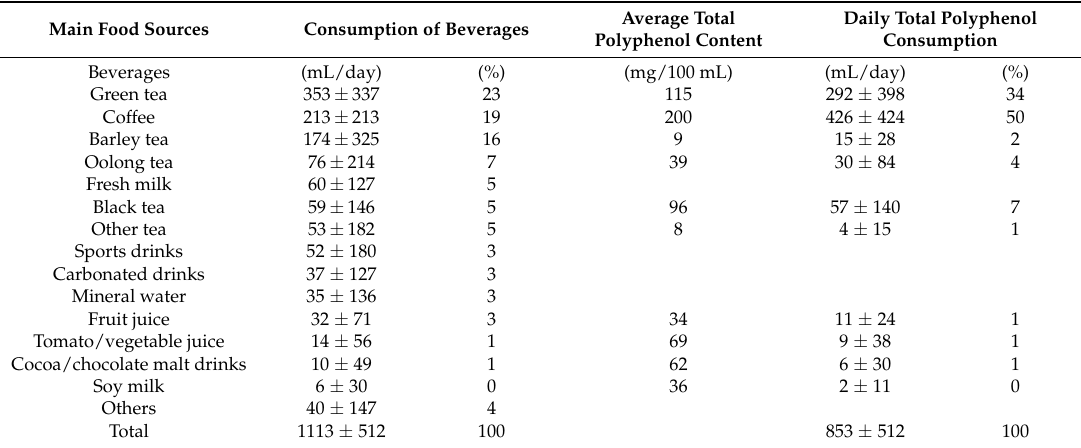
Table 1. Total polyphenol intake from beverages in the Japanese diet a